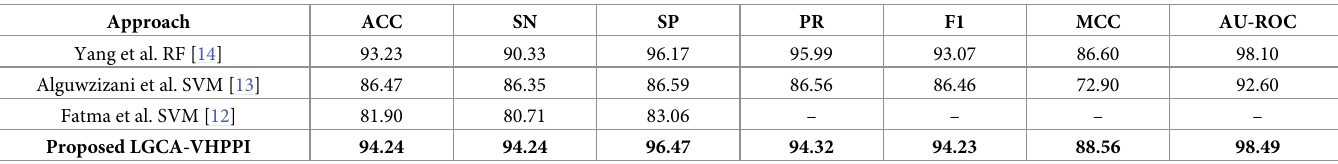
Table 4. Performance comparison of proposed LGCA-VHPPI with existing viral-host PPI predictors over benchmark DeNovo dataset [12] in terms of 7 different evaluation measures. Performance figures of DeNovo SVM [12], Alguwzizani et al. SVM [13], and Yang et al. RF on DeNovo Dataset [12] are taken from Yang et al. work